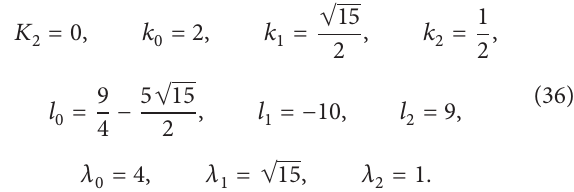
Figure 2: Nonlinear periodic-wave structure of the (2 + 1) - dimensional KGZ equation at time 𝑡 = 0 , given by (33)-(34) and (23) with parameters in (36) and function 𝑓(𝜂) satisfying (37) and elliptic modulus 𝑚 = 0.98 .